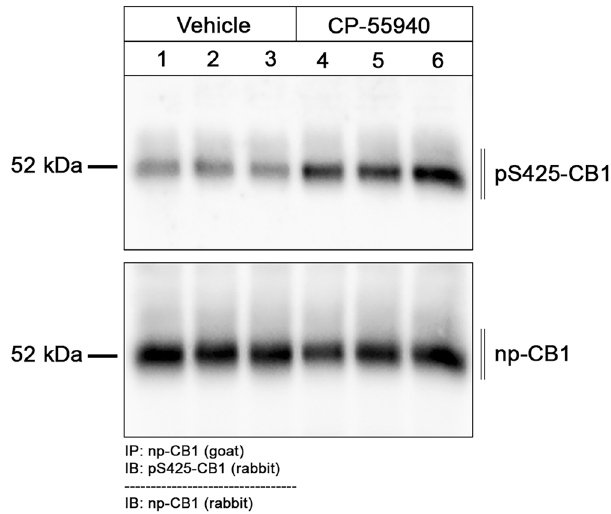
Fig. 9 Immunoblotting of phosphorylated CB1 in agonist treated mice. Six different wildtype animals were used. Number 1 to 3 were treated with vehicle and Number 4 to 6 with CP-55940 for 30 min. Organs were removed rapidly and frozen in liquid nitrogen After tissue preparations, CB1 receptors were extracted using goat np-CB1 bound to protein A beads. After blotting, the membranes were treated with the phosphosite-speci fi c rabbit antibody pS425-CB1, stripped (dashed line) and reprobed with rabbit phosphorylation-independent anti-CB1. Note that there is some CB1- phosphorylation constitutive signal in vehicle-treated mice. Molecular mass on the left in